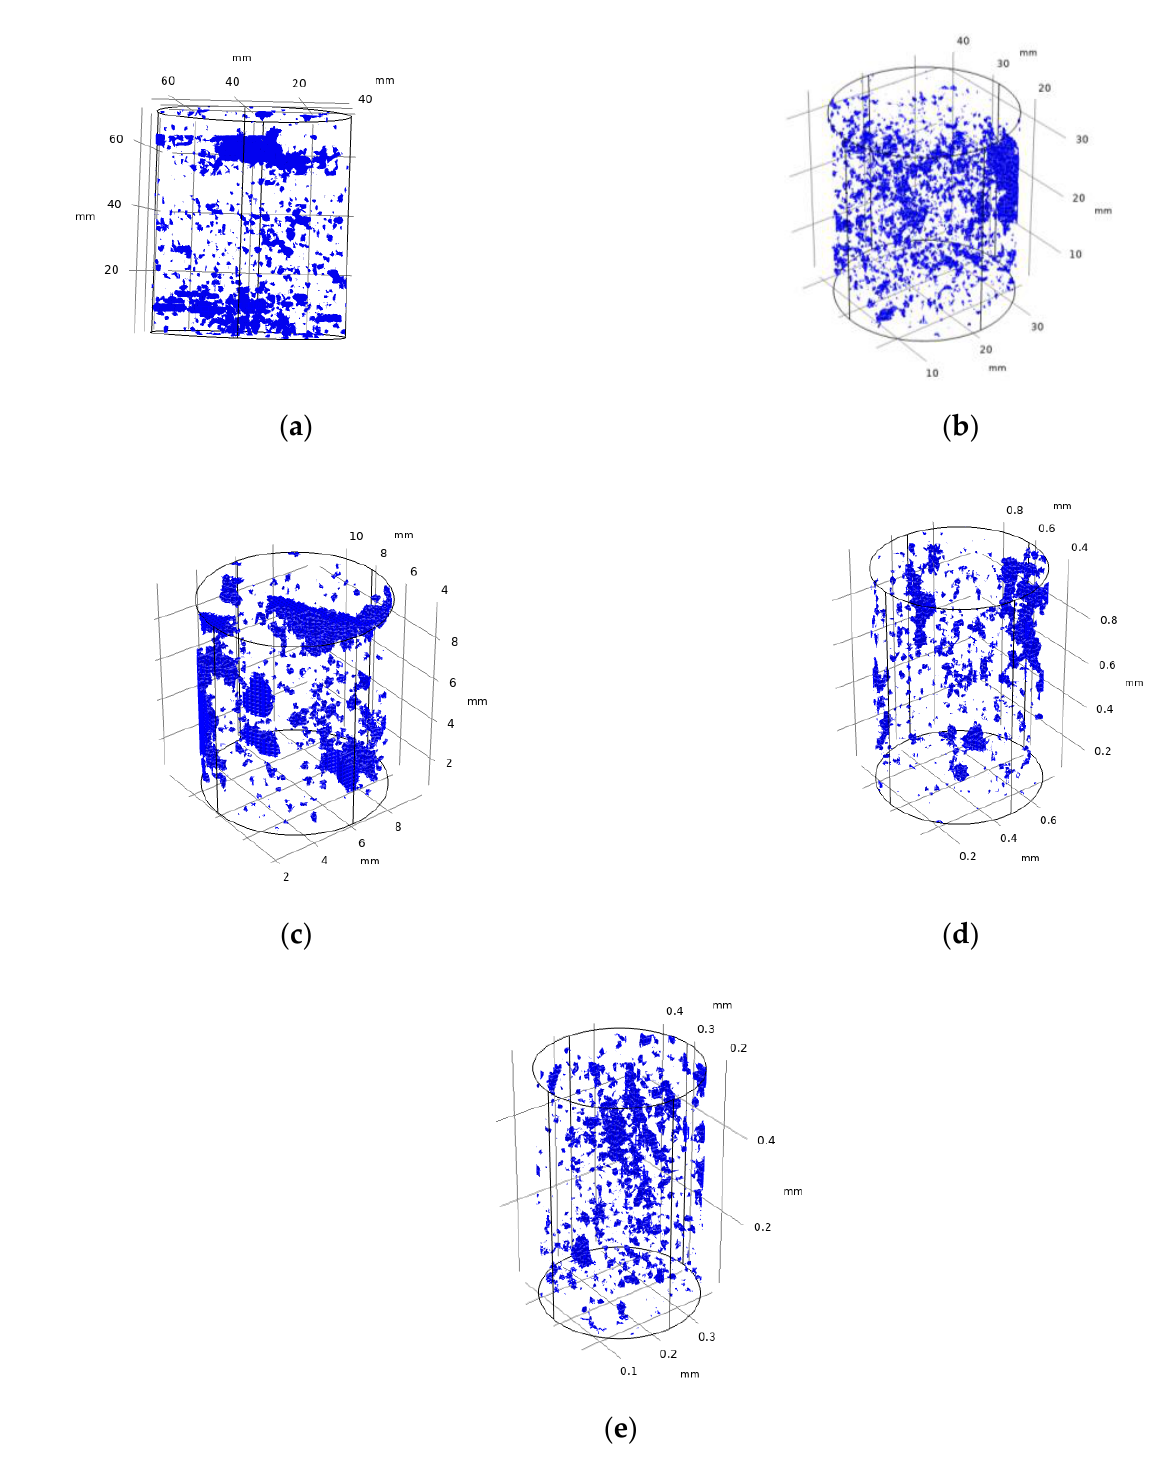
Figure 11. Pore – vug – fracture structure in a numerical model. ( a ) Sample C1; ( b ) Sample C2; ( c ) Sample C3; ( d ) Sample C4; ( e ) Sample C5.